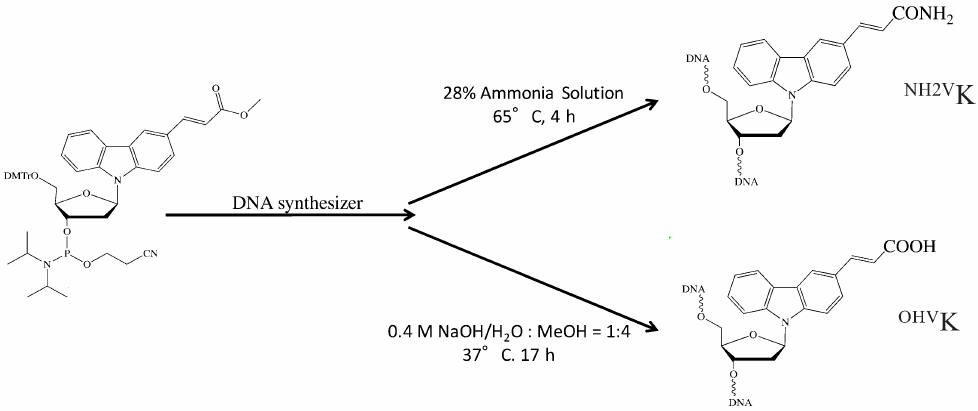
Scheme 2. Post-modification of photo-cross-linker in